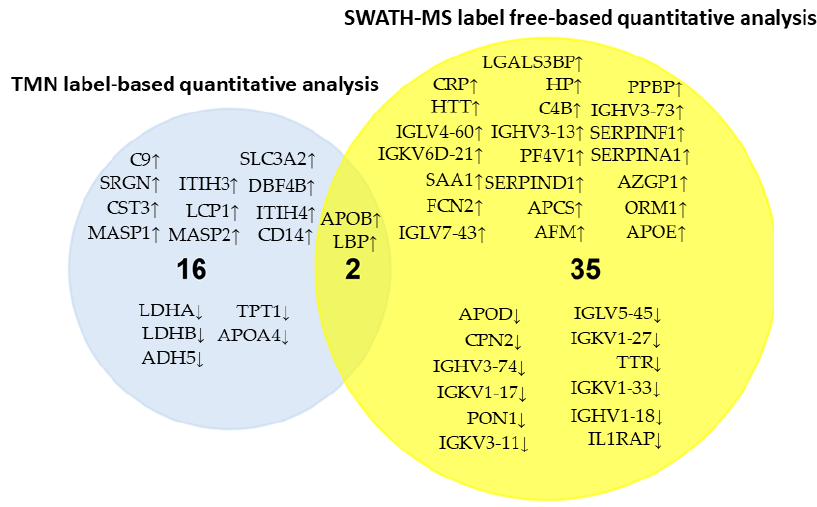
Figure 6. In silico validation after comparing the serum samples analysis from primary HER2-positive breast cancer cases to discover circulating proteins related to the NAC response with two quantitative proteomic methods: the isobaric TMT label-based and the SWATH-MS label-free ( ↓ denoted downregulation, ↑ denoted upregulation).